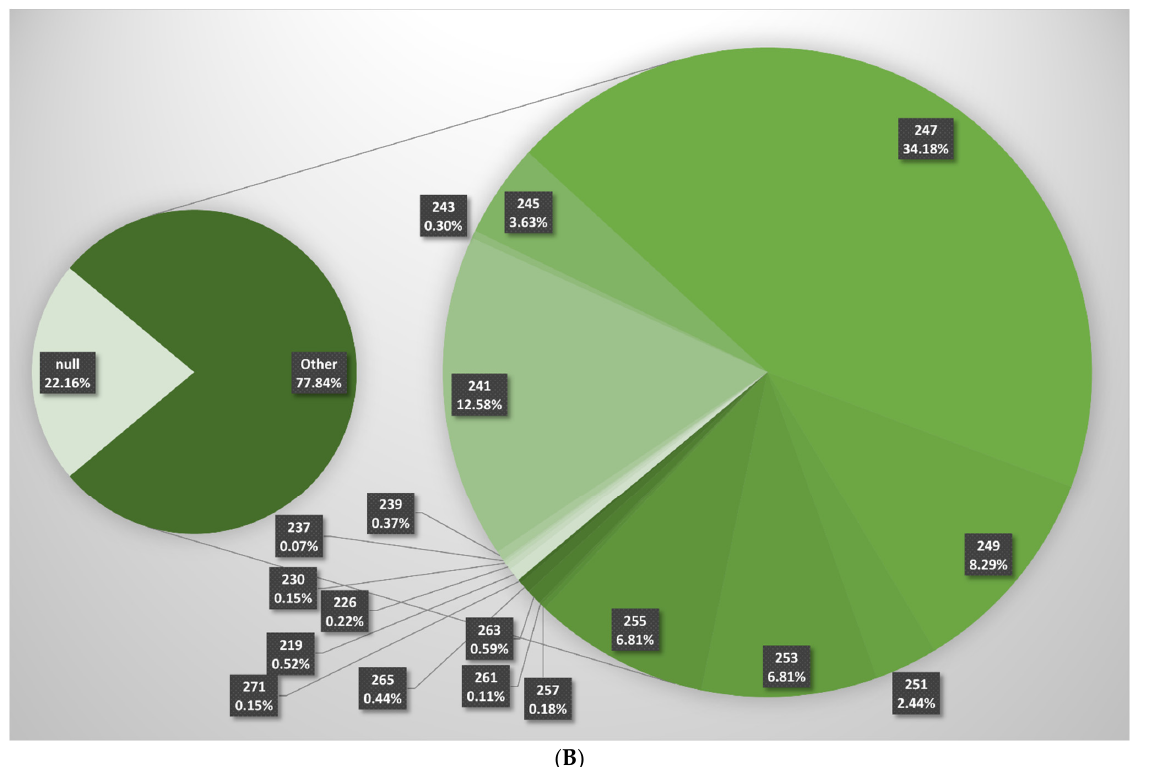
Figure 1. Ratio of alleles in SSR loci with relatively high estimated null allele frequency. Data from Riaz et al. [74], null allele frequencies estimated by MolMarker [16]. ( A ): VVIn73 locus; ( B ): VVMD21 locus.